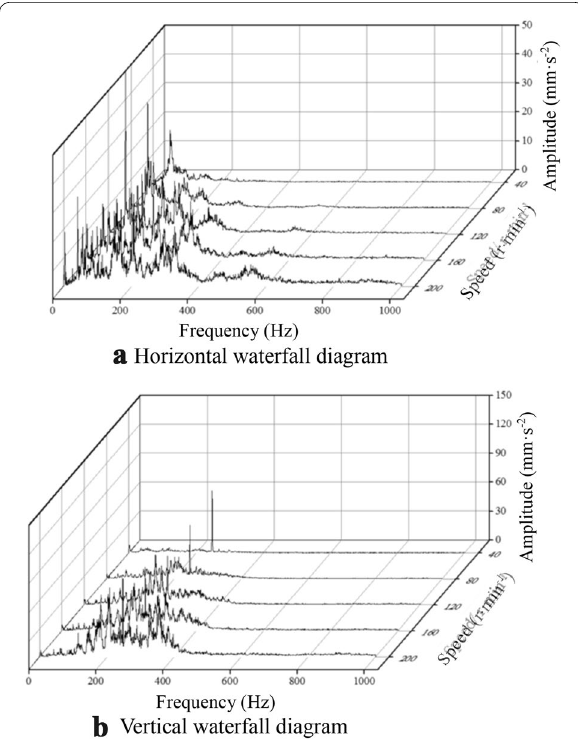
Figure 11 Variation of vibration amplitude of damping-enhanced bearing. a Horizontal waterfall diagram, b Vertical waterfall diagram